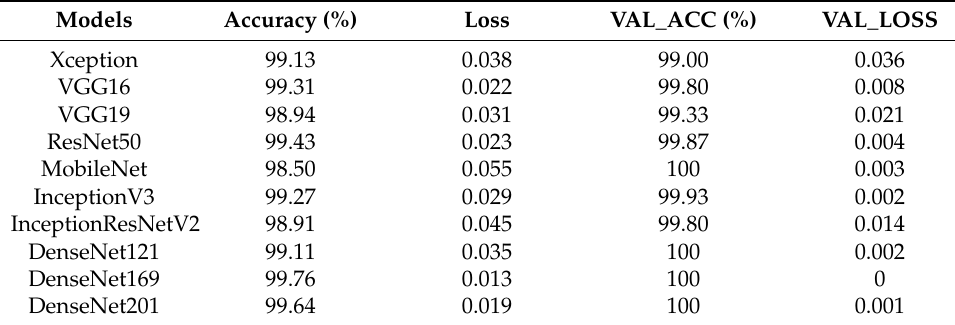
Table 1. Results of classification in precision.